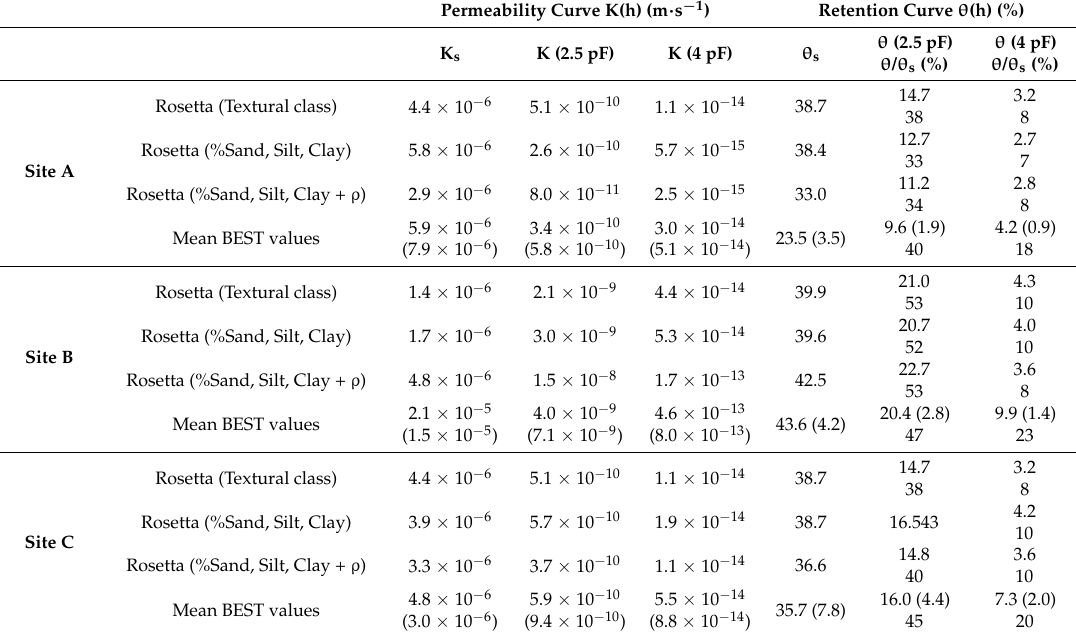
Table 3. Comparison between Rosetta estimations and experimental measurements of the curves K (h) and θ (h) (mean (standard deviation) of all the measurements carried out in each